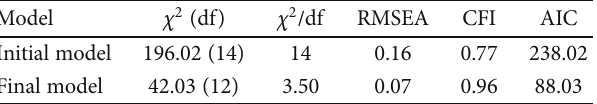
Table 3: Indices of fi t for initial and fi nal PSQI single-factor